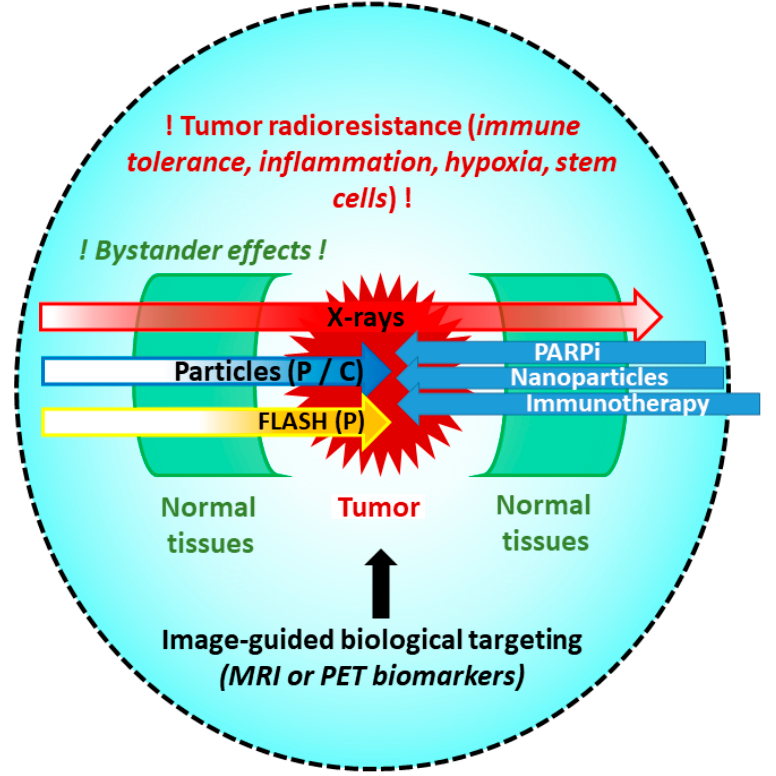
Figure 1. The radioresistance of cancer cells is a multifaceted mechanism, depending on the tumor type, location, and microenvironment. Radiosensitive organs near the tumor limit the irradiation dose using x-rays, but the use of particles (proton or carbon) can protect these normal tissues. In addition, carbon ions and FLASH irradiation improve the biological effect on the tumor, and combinations (PARPi, nanoparticle, immunotherapy) expand the possibilities of treatment. Image-guided radiotherapy increases the accuracy of the irradiation area and doses using biomarkers of radioresistant regions (hypoxia or stem cell niche).